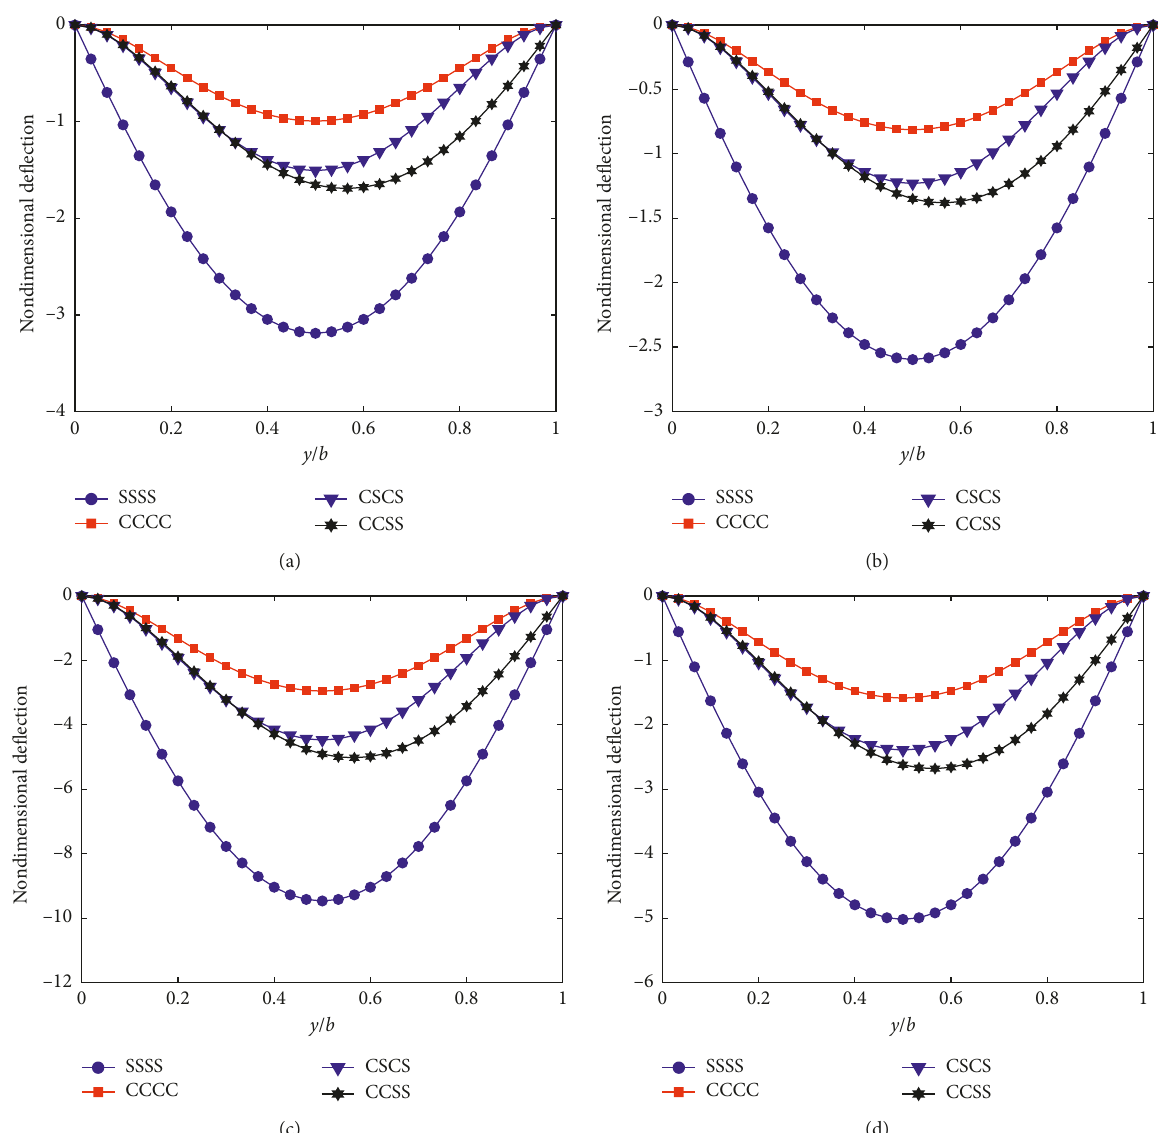
Figure 9: Nondimensional deflection of the plate along the line part x � a /2 with a / b � 1 and (a) h k / E m � 1, (c) h n / h m � 2, k st